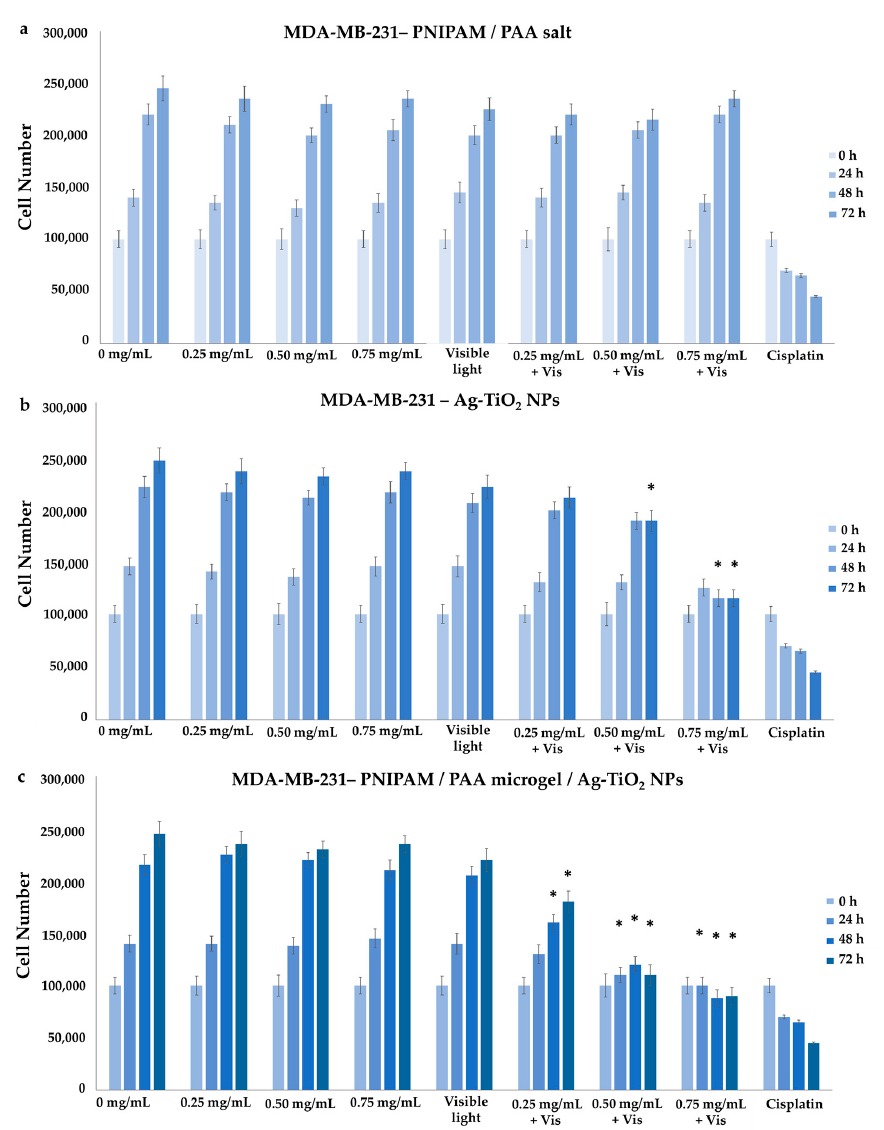
Figure 19. Growth rates of MDA-MB-231 cell line, with the addition of ( a ) PNIPAM/PAA salt, ( b ) Ag-TiO 2 NPs and ( c ) PNIPAM/PAA microgel/Ag-TiO 2 . There was no effect on cell proliferation in the presence of increasing concentrations of PNIPAM/PAA salt or Ag-TiO 2 before irradiation. Under irradiation with visible light, there was a decrease in cell population when 0.75 mg/mL of Ag/TiO 2 NPs were added. The photoexcitement of PNIPAM/PAA microgel/Ag-TiO 2 NPs resulted in a significant decrease in this cell proliferation. Samples treated with cis platin were used as positive controls in the experiment. In these series of experiments, * p < 0.05 was considered statistically